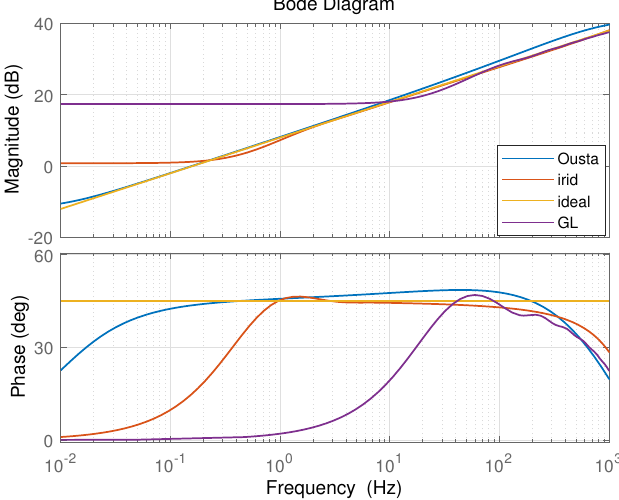
Figure 5. Case 2: 24th order discretization approximate Bode graph of s 0.5 in the frequency band [0.01, 1000] Hz.